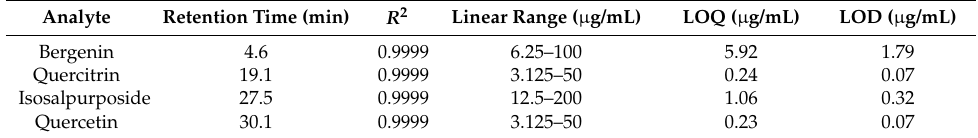
Table 2. HPLC data for the calibration graphs and limit of quantification of the four active compounds.